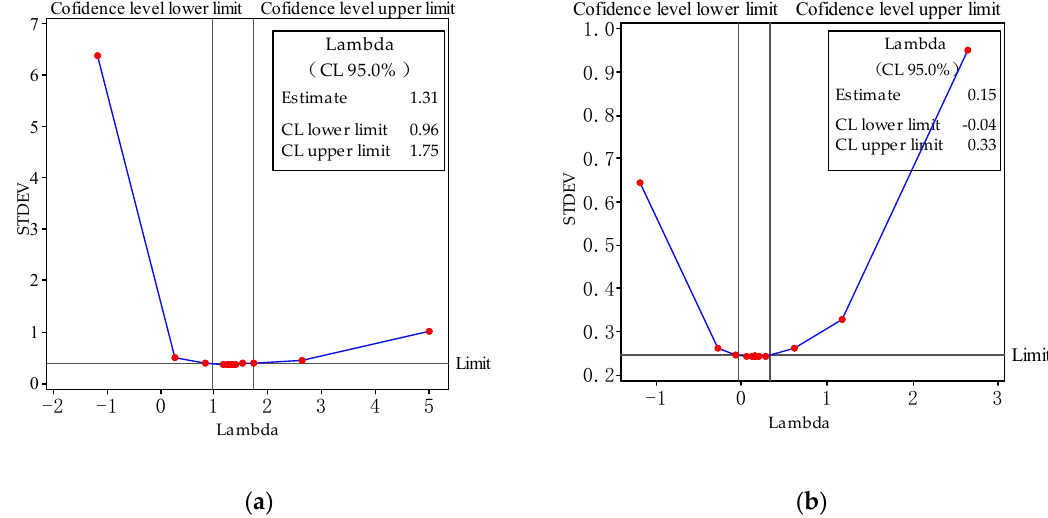
Figure 3. Maximum likelihood estimation of 𝜆 : ( a ) Kriging model’s estimation of 𝜆 ; ( b ) Calibrated kriging model’s estimation of 𝜆 .